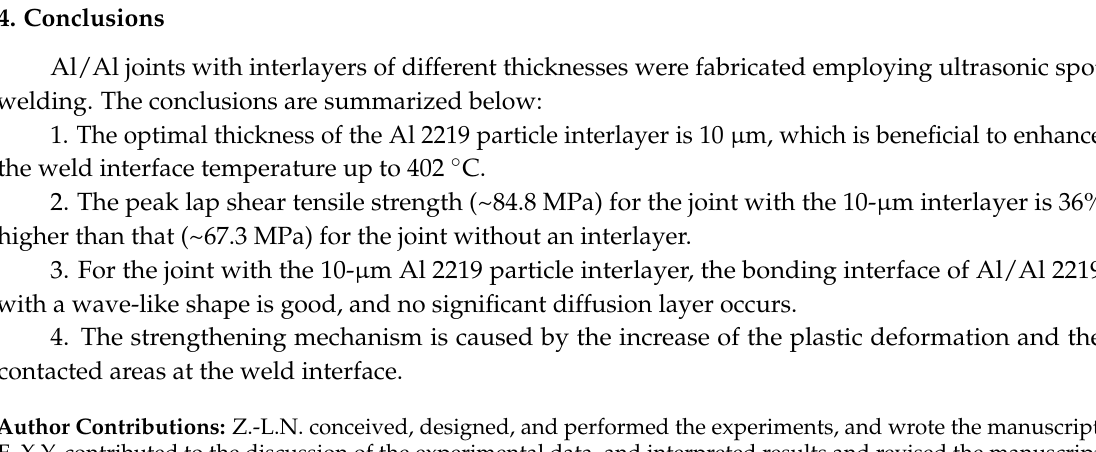
Figure 13. Flank face of the fracture path for the Al/Al joint with the 10- µ m